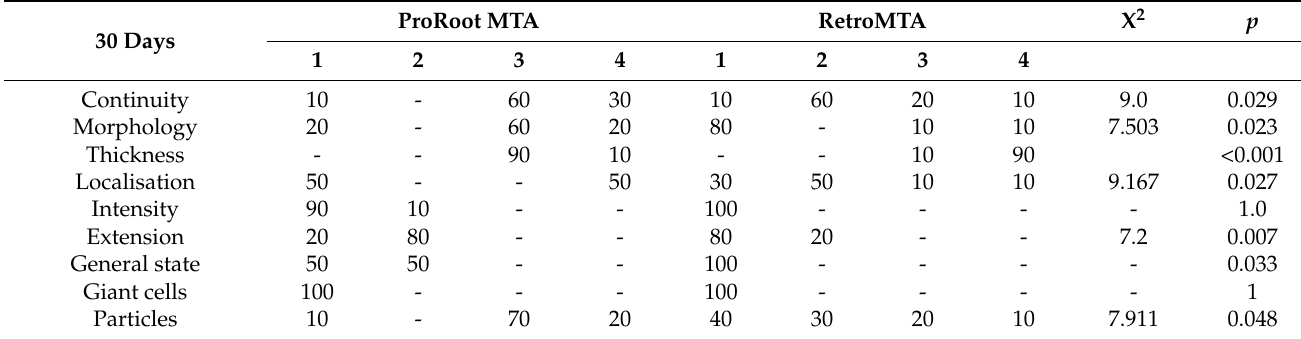
Table 5. Percentage of scores (%) attributed to each group in each criterion of hard tissue bridge after 30 days for both cement types: ProRoot MTA and RetroMTA.